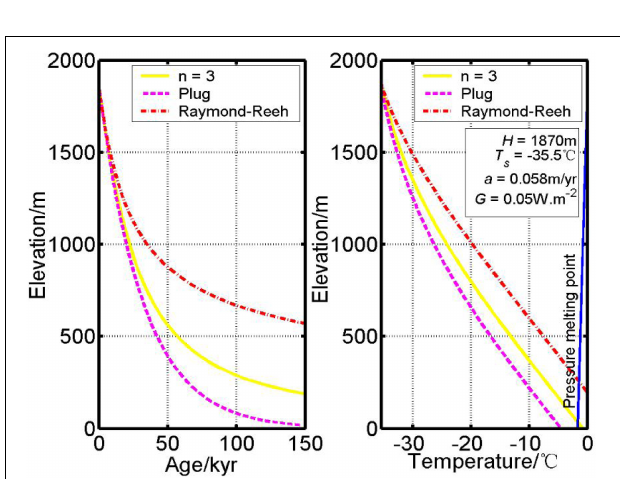
FIGURE 6 | Profiles of age depth and temperature depth at Taishan Station calculated for the input parameters of the ice thickness H , surface temperature T s , and accumulation a , and geothermal heat flux values G of 50 mW m − 2 from modeling using three flux shape functions in the ice model.